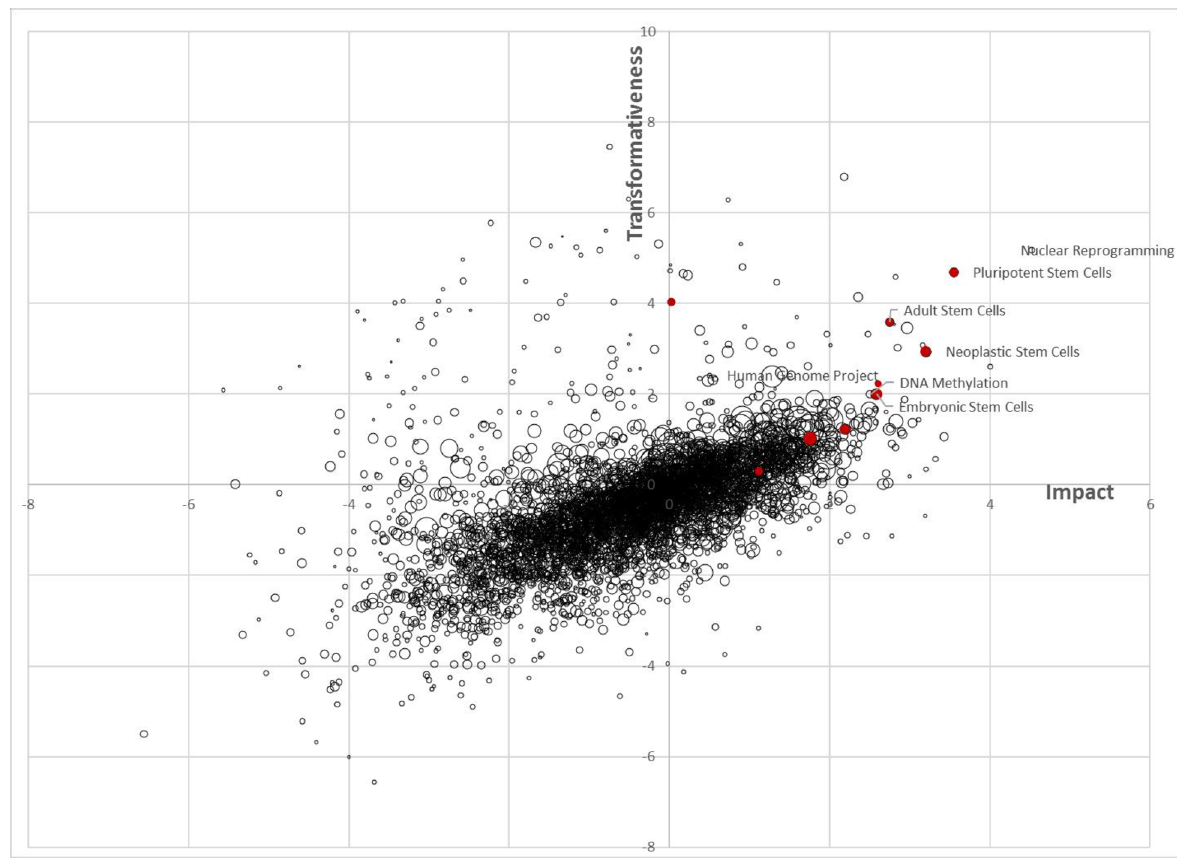
Fig 6. Ranking of fields in terms of impact and transformativeness across all periods (1982–2012). Field size determined by the number of (weighted) articles across all periods. Research on stem cells is shown in